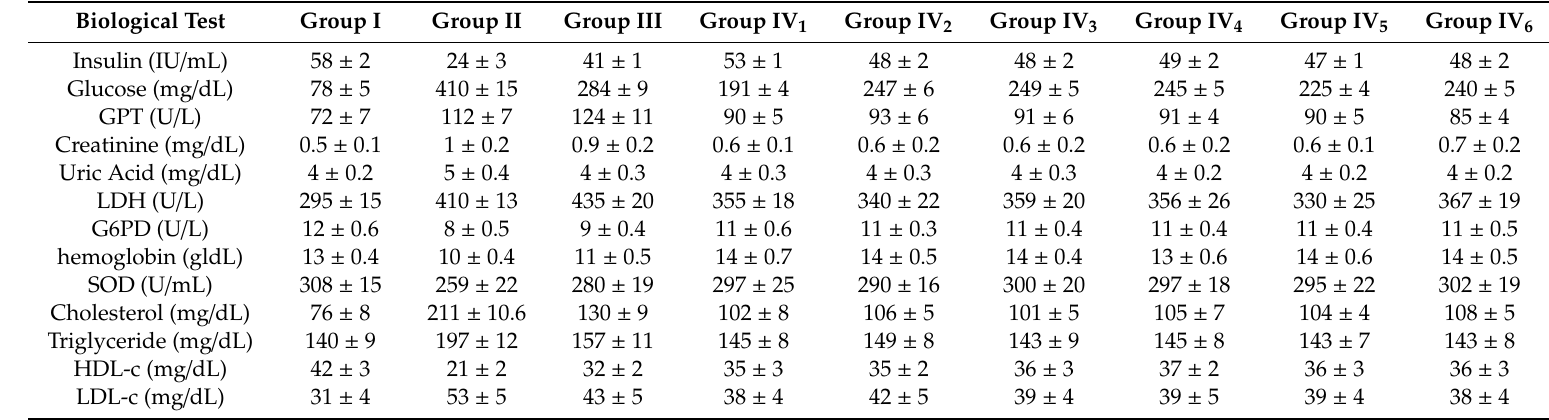
Table 4. E ff ect of vanadyl(IV) complexes (I–VI) on insulin hormone, blood glucose level, serum GPT enzyme, creatinine, uric acid level, lactate